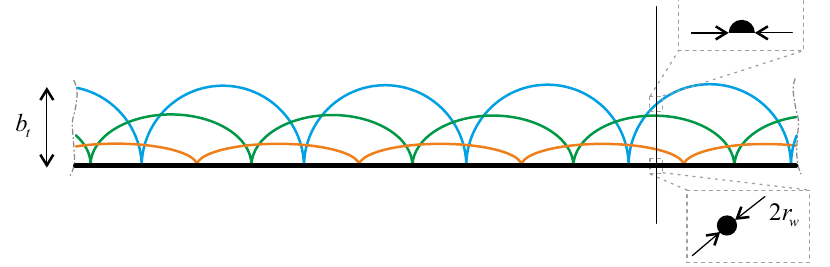
Figure 5. Schematic representation of a four-wire